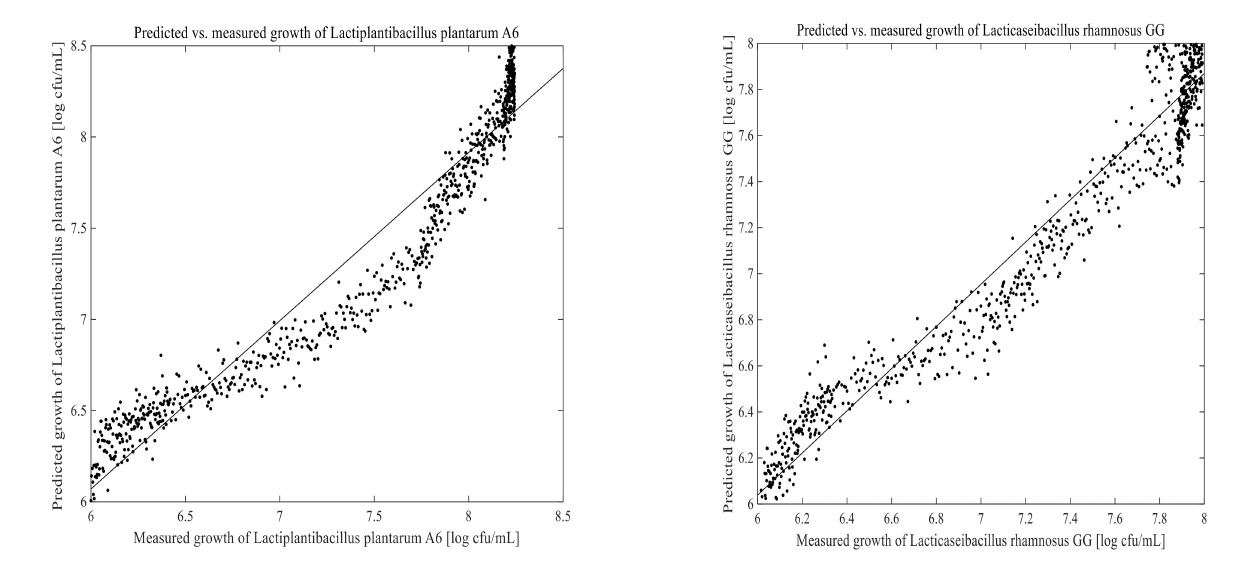
Figure 7. Predicted vs. measured cell growth in the fermentation of 4 g/100 mL of substrate inoculated with mixed strains of 6 log cfu/mL Lactiplantibacillus plantarum A6 and Lacticaseibacillus rhamnosus GG; predicted with partial least-squares regression using four principal